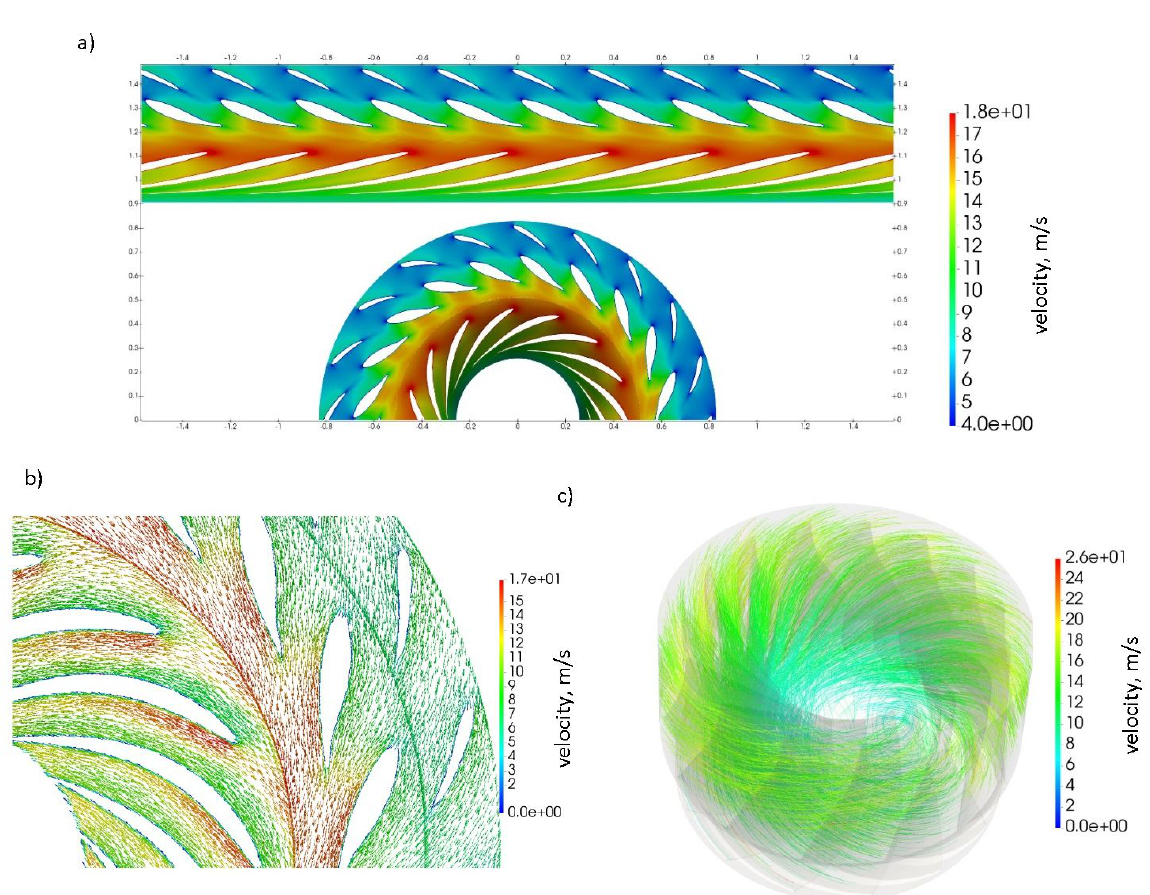
Figure 4: The flow structure in analyzed turbine : a) the distribution of velocity, b) velocity vectors, c) streamlines